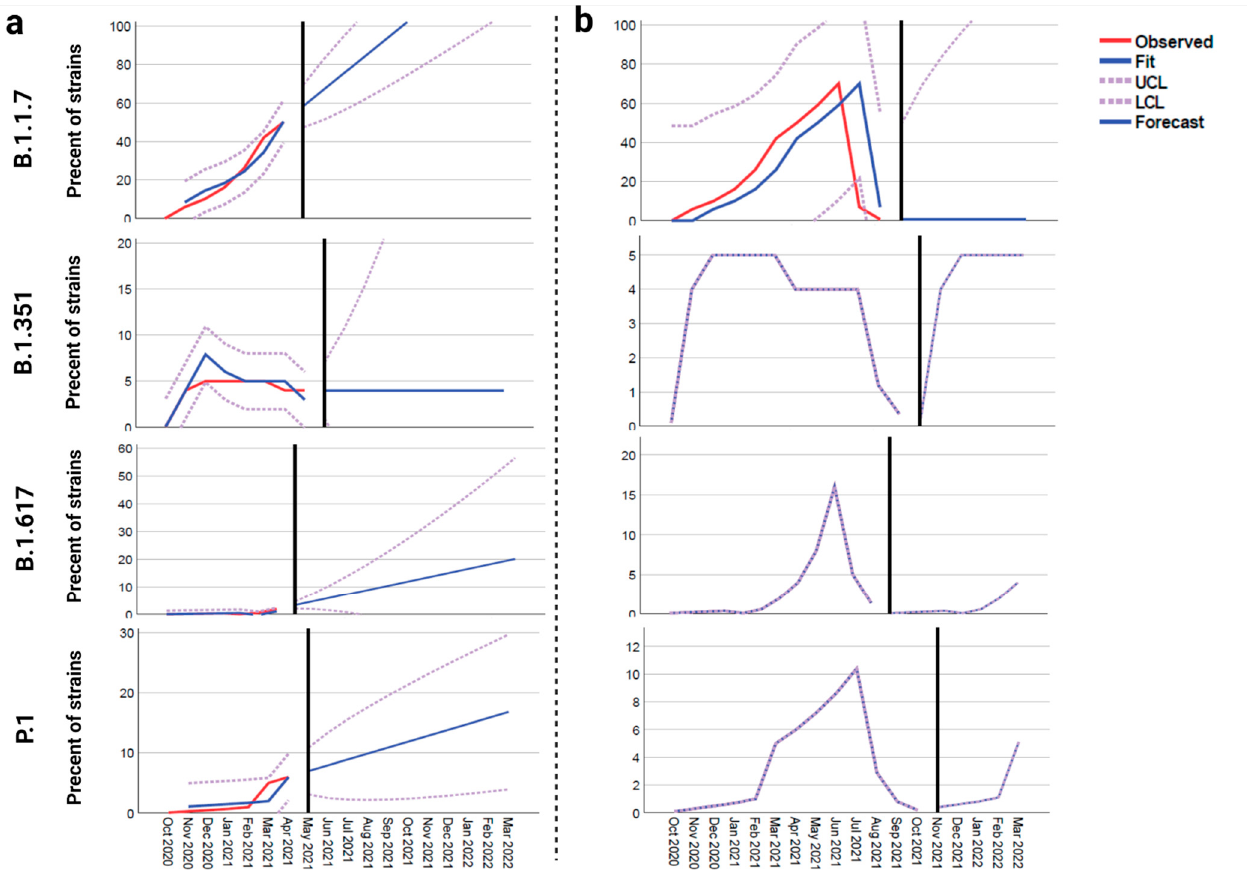
Figure 2. The forecast models of the proportion of different novel SARS-CoV-2 variants in North America. ( a ) Model 1 pre-vaccination, ( b ) model 2 post-vaccination and assumption of occurrence of herd immunity (modeled based on the affinity of neutralizing antibody to the S-RBD protein of B.1.1.7, B.1.617, B.1.351, and P.1 variants).